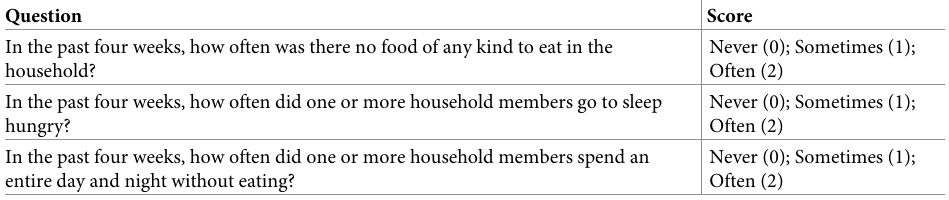
Table 1. The household hunger Scale assesses the presence and severity of food insecurity using three questions from the Household Food Insecurity Access Scale (HFIAS) which have been shown to be culturally invariant. Food security is classified into one of three categories: little to no hunger in the household (score of 0–1), moderate hunger in the household (score of 2–3), or severe hunger in the household (score of 4–6) [34]. Question In the past four weeks, how often was there no food of any kind to eat in the household? In the past four weeks, how often did one or more household members go to sleep